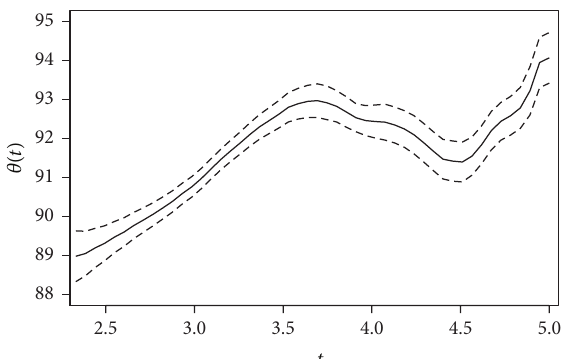
Figure 3: The estimator and 95 % pointwise confidence interval for 𝜃(𝑡) .